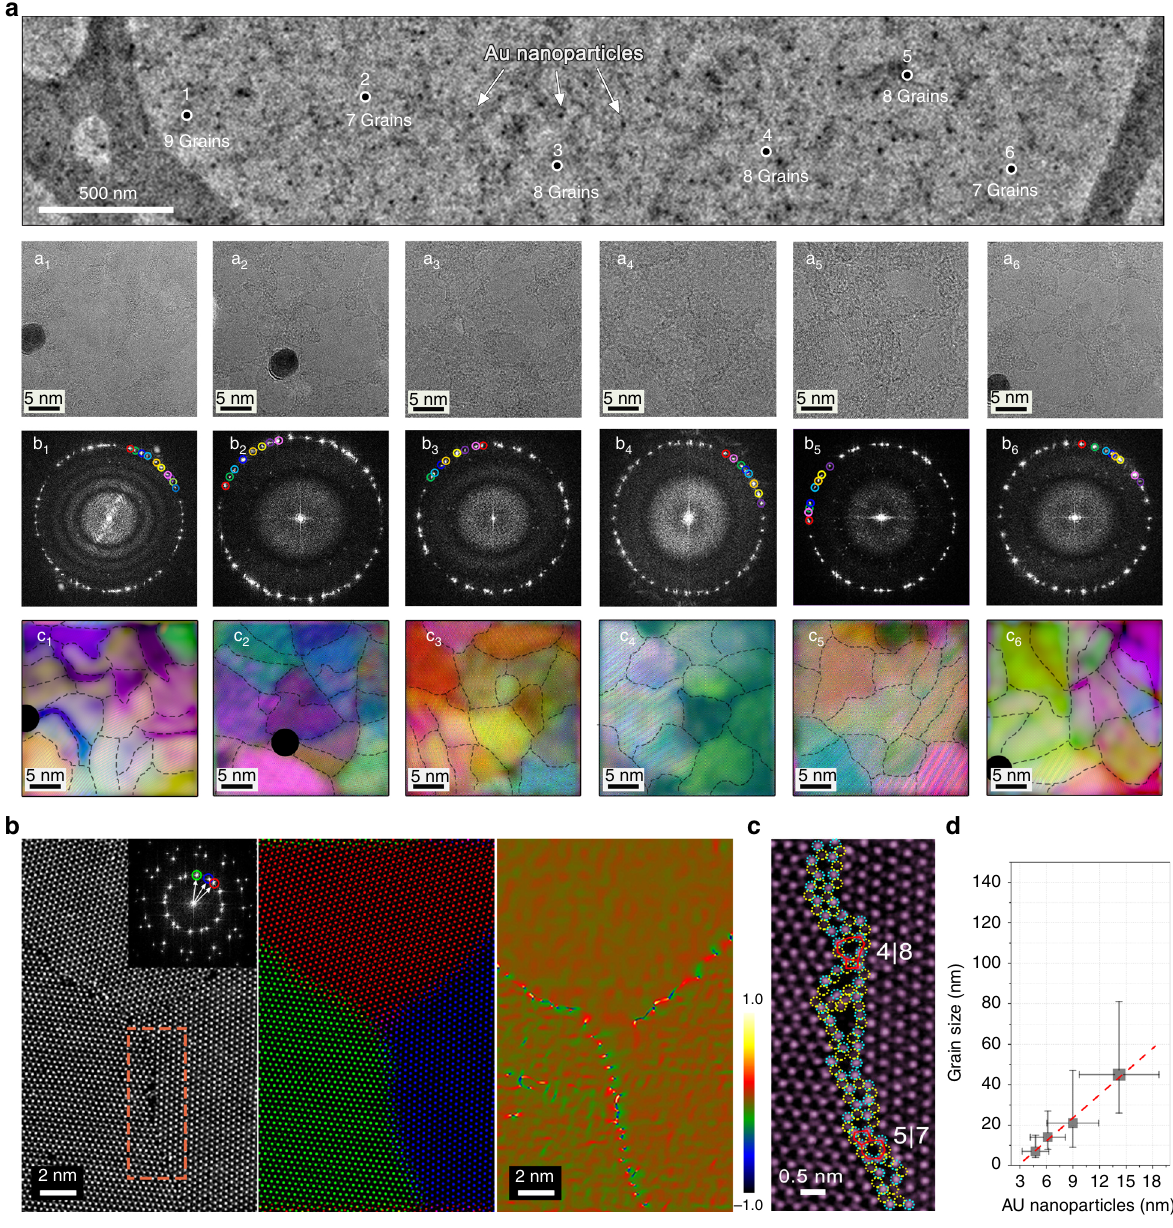
Fig. 2 Atomic structure of the TMD nanograin fi lm. a TEM image of the 1 – 3 L MoS 2 nanograin fi lm, showing a uniform and continuous atom-thin layer with Au nanoparticles (dark spots). Top panel (a1 – a6): HRTEM images from regions 1 – 6. Middle panel (b1 – b6): Fourier transforms (FFTs) of regions 1 – 6 from the corresponding TEM image. Bottom panel (c1 – c6): false-colored frequency fi ltered (IFFTs) images of the same regions. Grains with different orientations give rise to distinct sets of rotated spot patterns in the FFTs, as indicated by colored circles in the middle panel (b1 – b6); in turn, the localization of the grains can be visualized in real space by color coding the corresponding contribution to the IFFT of a given set of diffraction spots, and overlaying the IFFTs into a composite colored image (in bilayer regions, the colors are combined). In order to better visualize the different grains, the grains are highlighted in the IFFT images with black-dashed lines. b HAADF STEM investigation of MoS 2 grains. Left: HAADF STEM image showing the GBs between three MoS 2 grains. Inset on the left fi gure: Fourier transform of the image showing three distinct sets of MoS 2 diffraction patterns with rotation angles of 11.6° and 25.6°. Middle: composite color-coded IFFT image. Right: dilatation map of b after applying GPA routine to the monolayer MoS 2 . c Higher magni fi cation atomic resolution HAADF STEM image of the brown-dashed line marked region in b , showing the detailed atomic structure of the GB, which is composed of 5|7 and 4|8 rings. Mo atoms are marked with indigo dotted circles and S atoms marked with yellow dotted circles. d Grain size dependence on Au nanoparticle size (average diameter) in the MoS 2 nanograin fi lm. The error bars of Au nanoparticles are extracted from the full-width at half maximum in Fig.